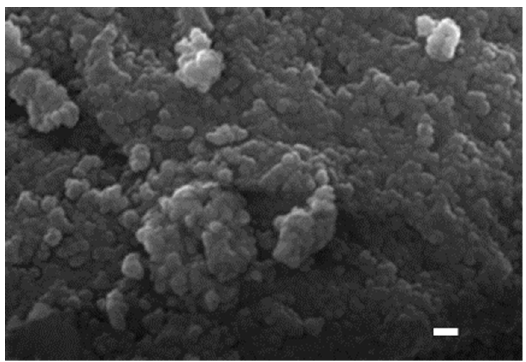
Figure 4. FE-SEM image of YZrO calcined at 900 °C. A scale bar in the photo indicates 100 nm. Even at a high calcination temperature of 1050 °C, the result of Rietveld analysis was not satisfied within the fitting errors because of low diffraction intensity. Figure 5 shows the step-scanning XRD pattern of YZrO sample calcined at 1200 °C. We confirmed diffraction angles are the same between YZrO calcined at 1050 and 1200 °C. Thus, Rietveld analysis was performed in a YZrO sample calcined at 1200 °C to refine the structure parameter (Figure 5). We confirmed that the sample was composed of defect fluorite-type Y 2 Zr 2 O 7 , but not pyrochlore. Table 5 lists the refined structure parameters of Y 2 Zr 2 O 7 .